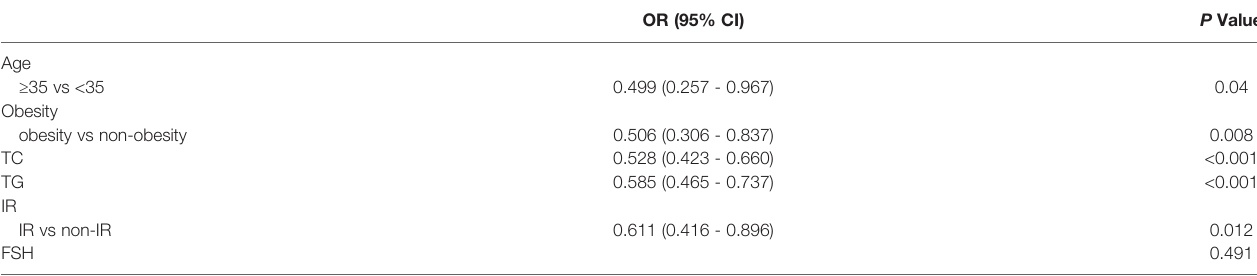
TABLE 2 | Multivariate logistic regression analysis of live birth based on data in the training cohort.